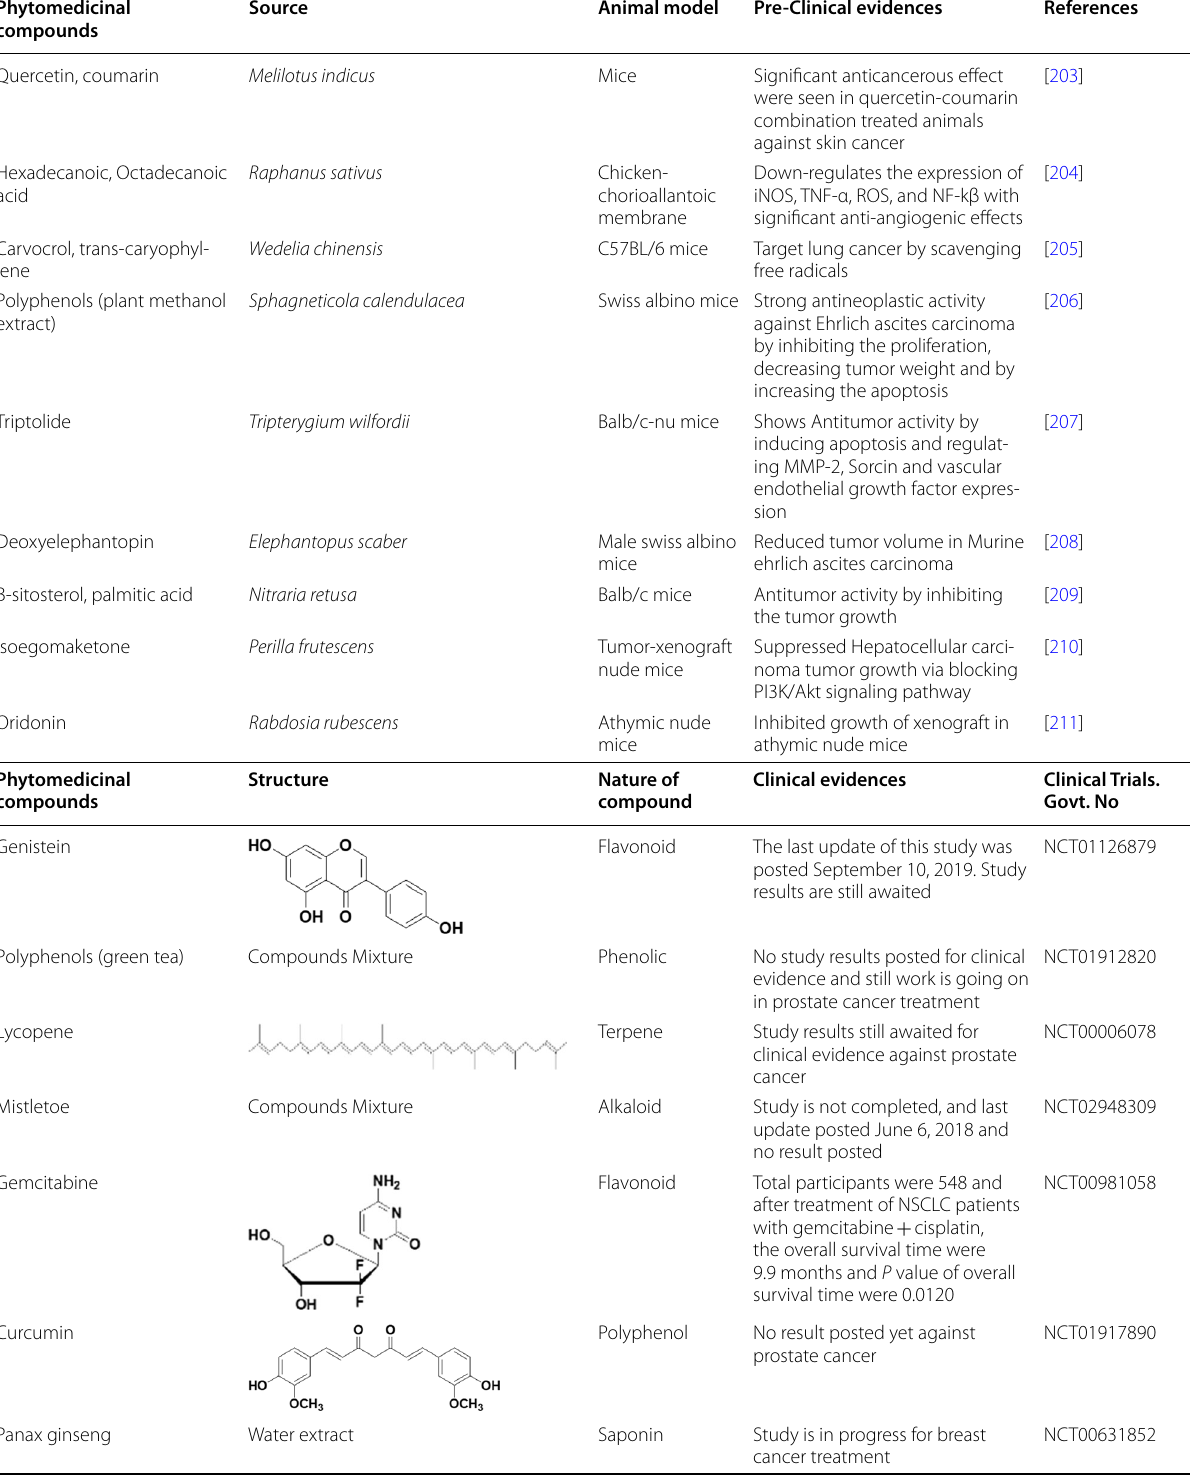
Table 2 Phytomedicinal compounds in pre-clinical and clinical trials Phytomedicinal